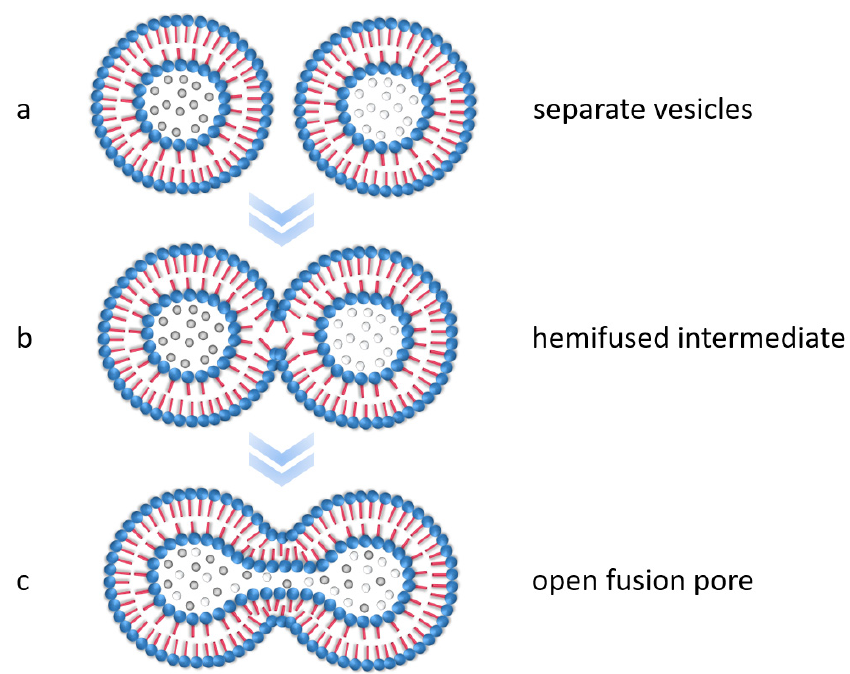
Figure 1. Schematic representation of the basic processes in membrane fusion. ( a ) Before the membranes come in contact, ( b ) after the outer membranes come in contact and fuse to form a hemifused intermediate, and ( c ) after the fusion pores open through reorganization processes. Figure inspired by [51].